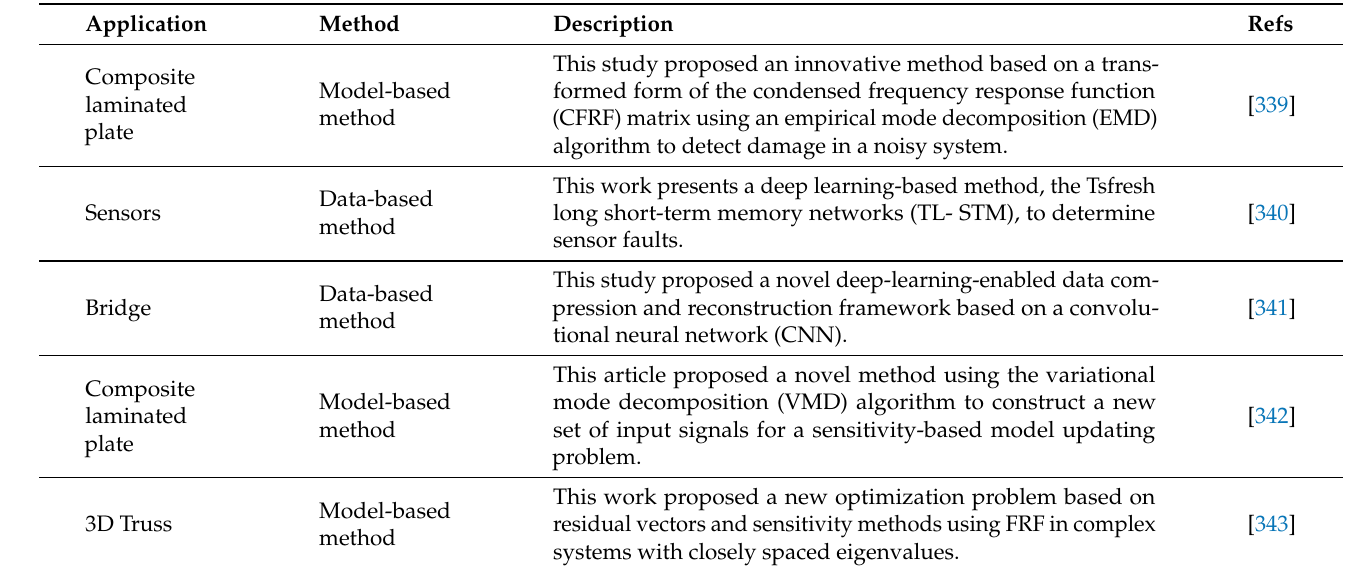
Figure 11. Flowchart of model-based and data-based methods. Table 16. Recent papers using model- and data-based methods in SHM